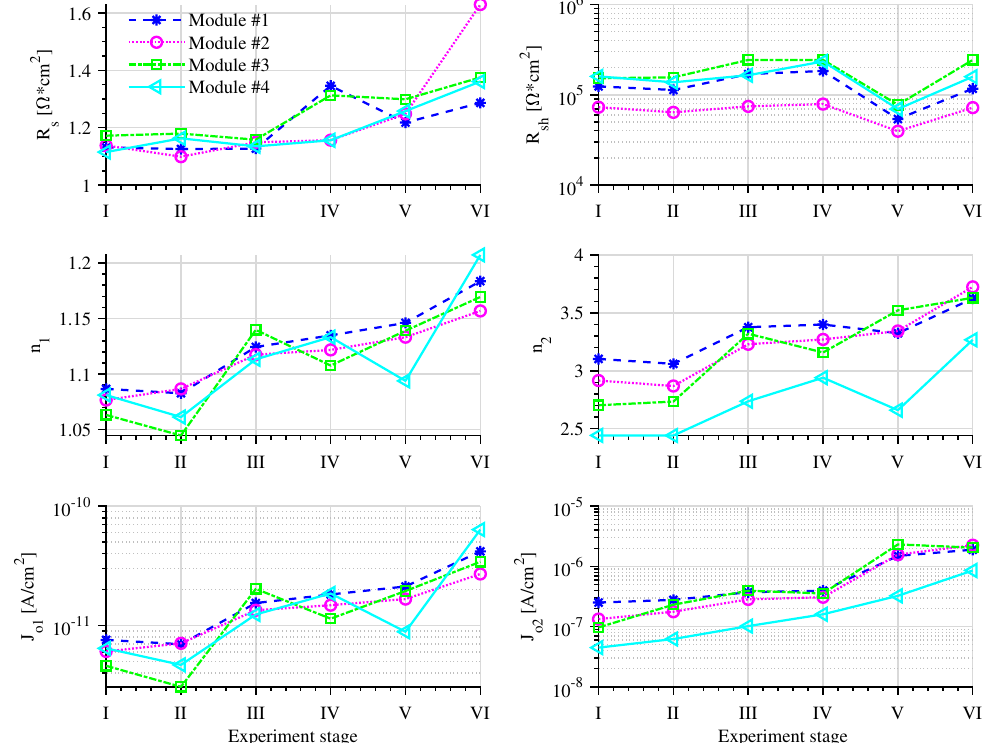
Figure 6. Degradation of the two-diode model parameters determined by curve fitting module dark I-V measurements taken at 25 °C after each experiment stage. Description of experimental stages and power losses of modules (#1–#4) are given in the Table 1 and Figure 3a, Figures A4a and